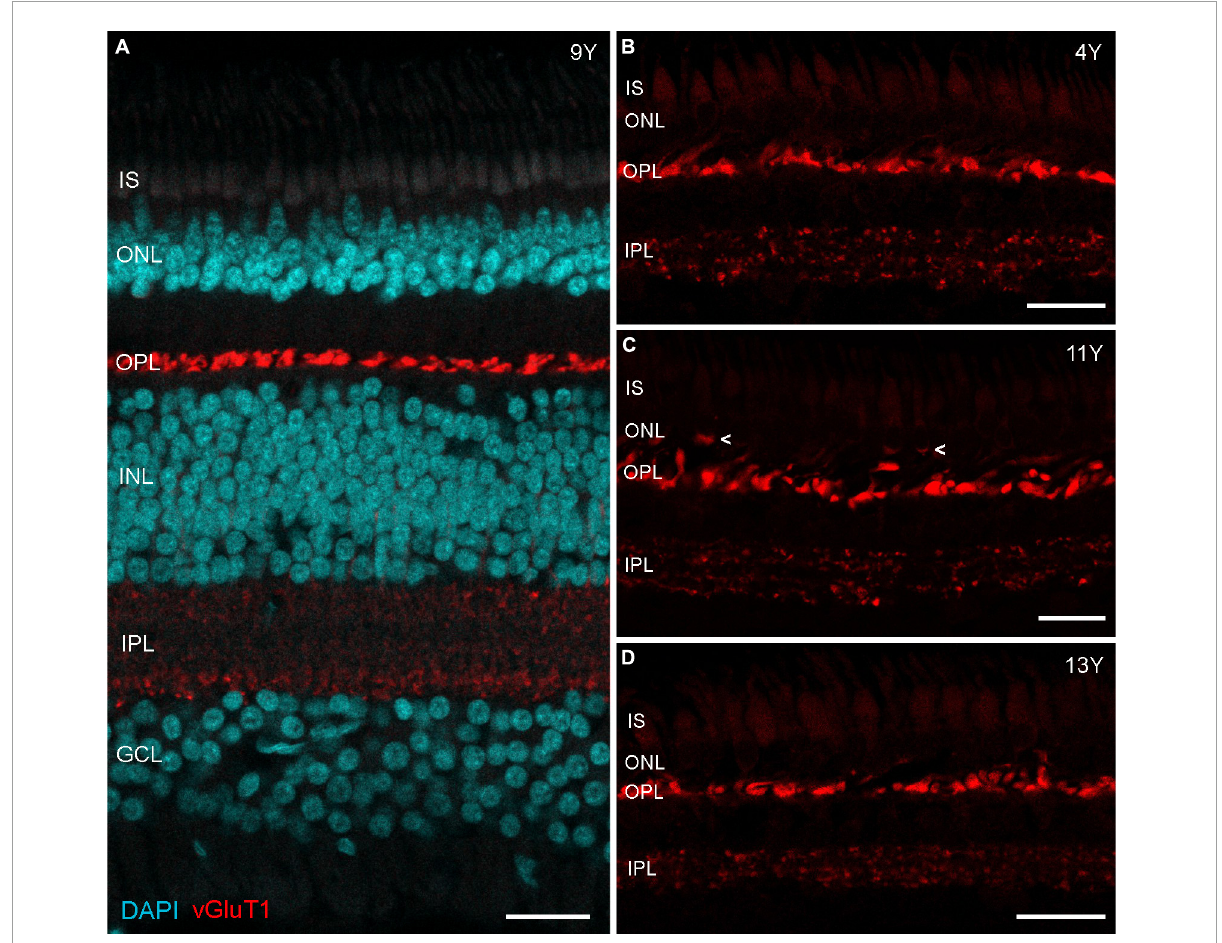
FIGURE3 vGluT1 expression in aged marmoset retina. (A) vGluT1 staining in the central retina of a 9-year-old animal with strong expression in the OPL and weak expression in the IPL. (B–D) vGluT1 staining in the peripheral retina of a 4-year-old animal and two aged animals. Only the section of the 11-year-old animal showed some vGluT1 staining in the ONL (arrowheads in C ), the peripheral retina of the 13-year-old animal appeared normal. IS, inner segments; ONL, outer nuclear layer; OPL, outer plexiform layer; INL, inner nuclear layer; IPL, inner plexiform layer; GCL, ganglion cell layer. Scale bars, 25 µ